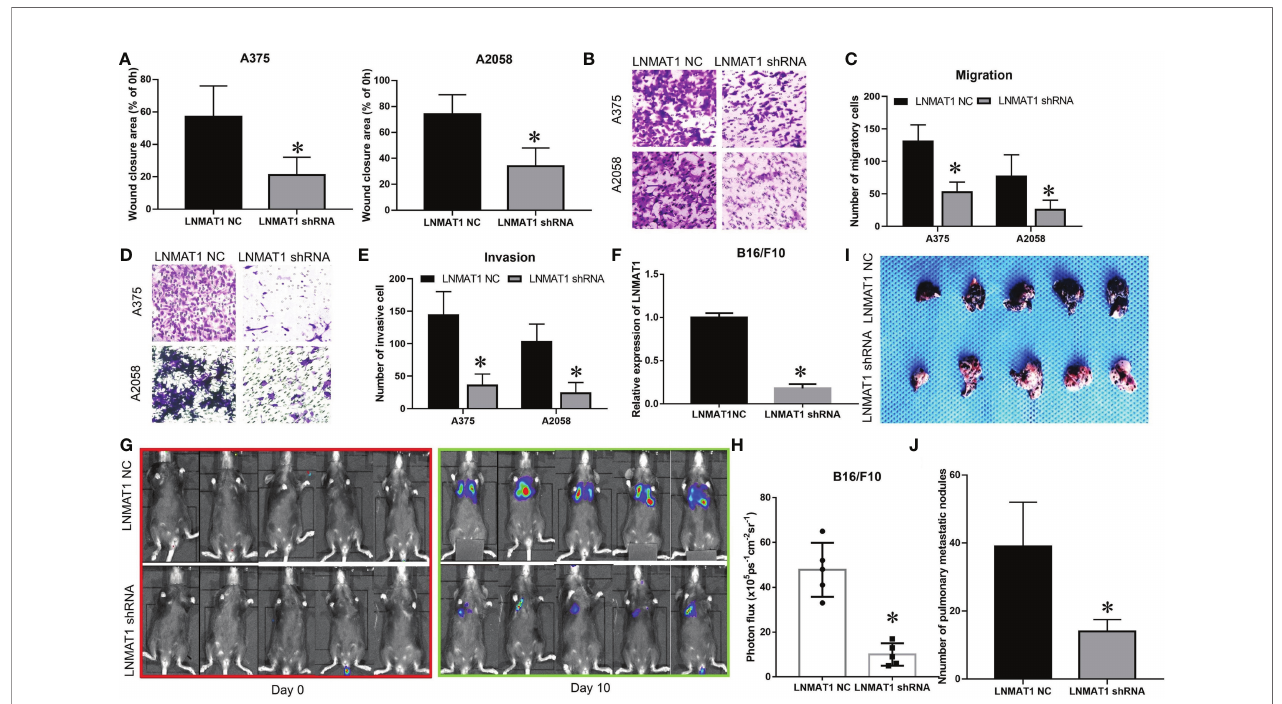
FIGURE 2 | LNMAT1 promotes the invasion-metastasis cascade in MM in vitro and in vivo. (A) MM cells were infected with LNMAT1 NC or shRNA. Wound healing assays were performed to detect the migratory distance in the indicated groups. The representative results of three independent experiments are shown; (B, C) Transwell assays were performed to detect the number of migratory cells in the indicated groups. The representative results of three independent experiments are shown; (D, E) Transwell assays were performed to detect the number of invasive cells in the indicated groups. The representative results of three independent experiments are shown; (F) The silencing effects of LNMAT1 shRNA in B16/F10 cells; (G, H) Bioluminescence images at day 0 and day 10 (G) and statistical analysis (H) of bioluminescence at day 10 (lung colonization) in C57/B6 mice (n = 5) that were intravenously injected with LNMAT1 stably silencing B16/F10 cells or NC cells; (I, J) Bright fi eld imaging (I) and number of metastatic nodules (J) at day 10 in the lungs of C57/B6 mice (n = 5) that were intravenously injected with LNMAT1 stably silencing B16/F10 cells or NC cells. Data are shown as the mean ± S.E. *P < 0.05, ns, not signi fi